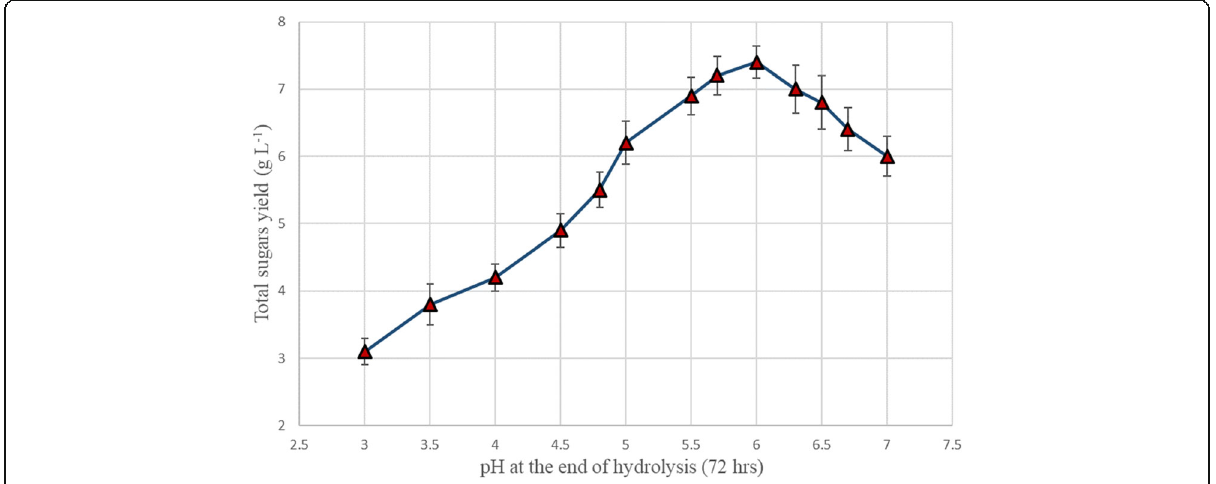
Fig. 4 Total reduced sugar concentration for different pH solution at the end of the hydrolysis (72 h)